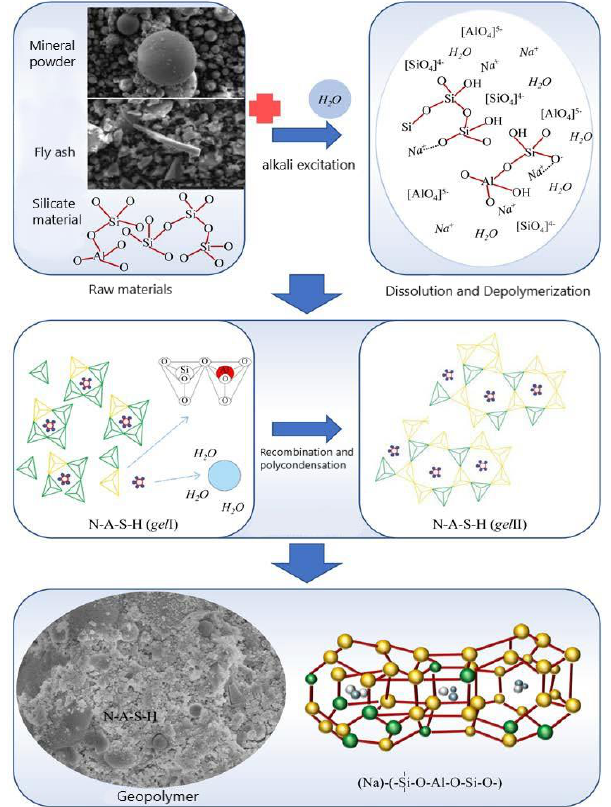
Figure 13. The schematic diagram of reaction mechanism.